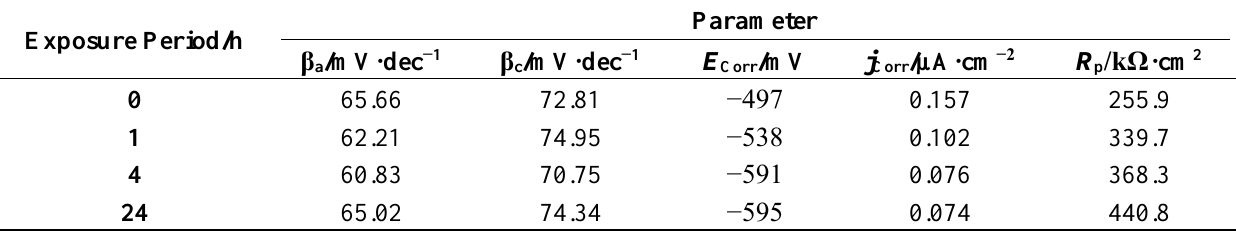
Table 1. Potentiodynamic polarization parameters obtained for γ-TiAl alloy in 3.5% NaCl solutions at room